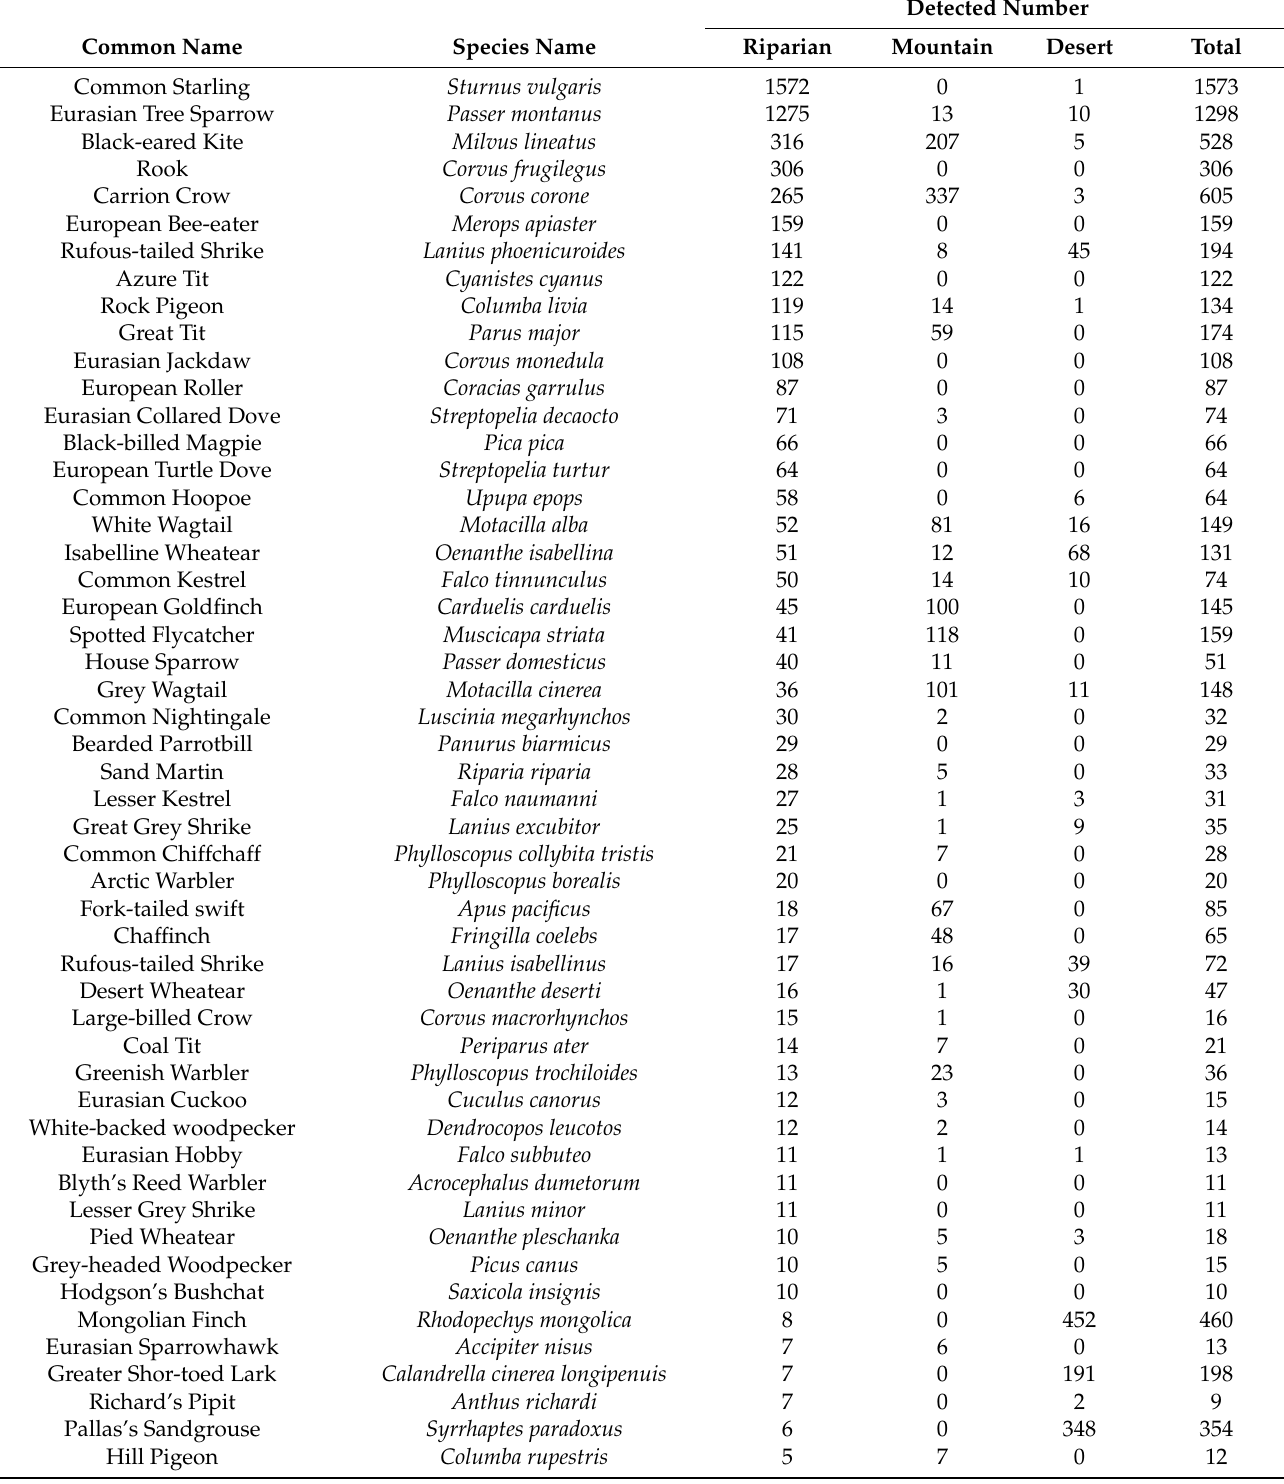
Table A1. Bird species detected in mountain, riparian and desert